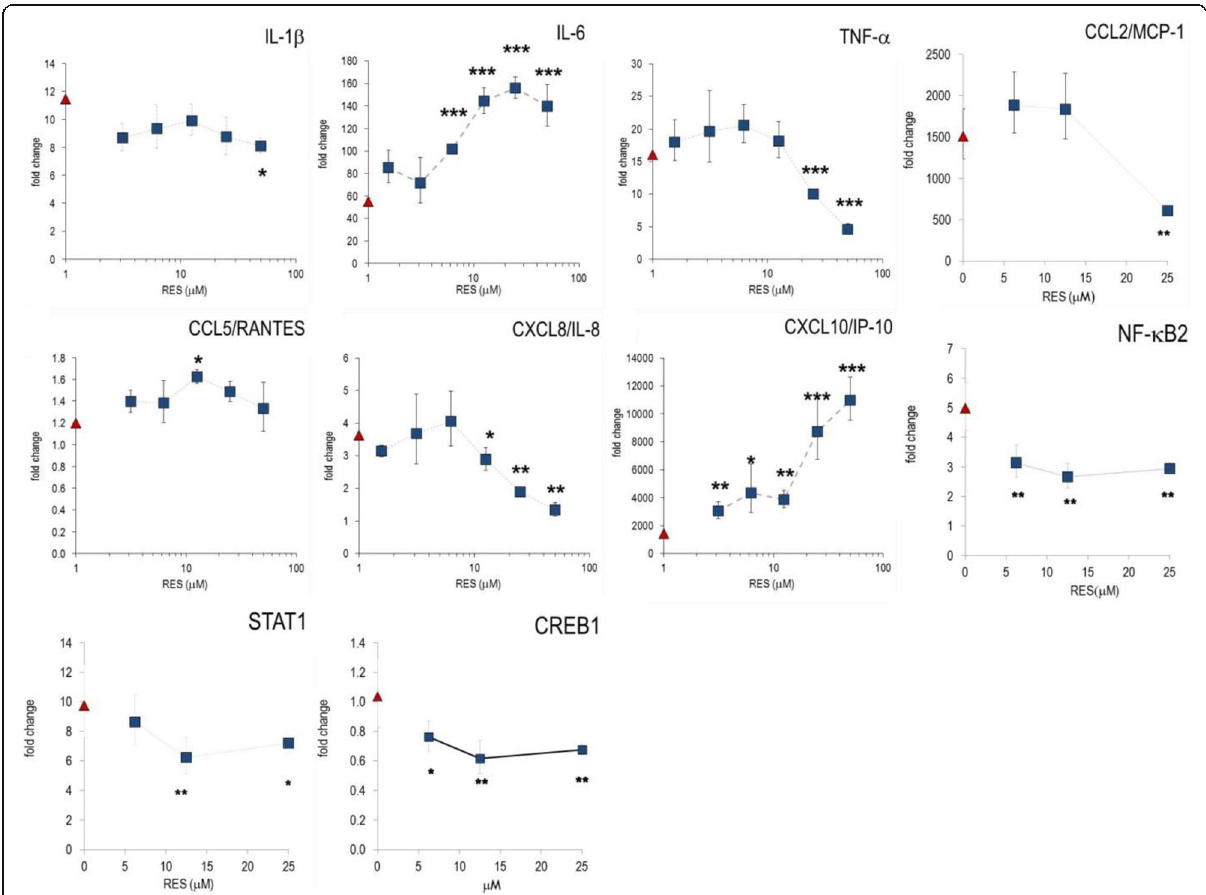
Fig. 5 Effect of RES on gene expression in activated PBLs. Freshly isolated PBLs from a healthy donor were incubated with RES and stimulated with LPS for 1-12 h. Gene expression was quantified by RT-PCR and the data expressed as fold change compared to levels observed in unstimulated cells. Mean ± errors (see reference [11]) of triplicate cell culture are given. Only the time point, where maximal stimulation for a given gene was observed, is shown. * p < 0.05, ** p < 0.01, *** p < 0.001 (versus LPS-stimulated